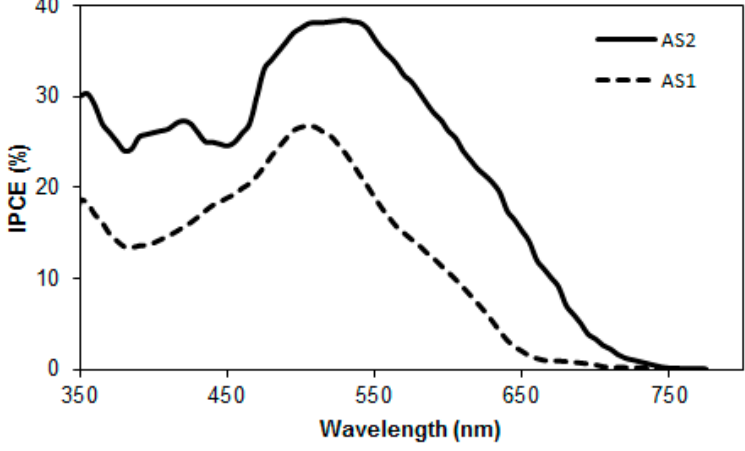
Figure 8. IPCE spectra of AS2 and AS1 with PC 61 BMblends.